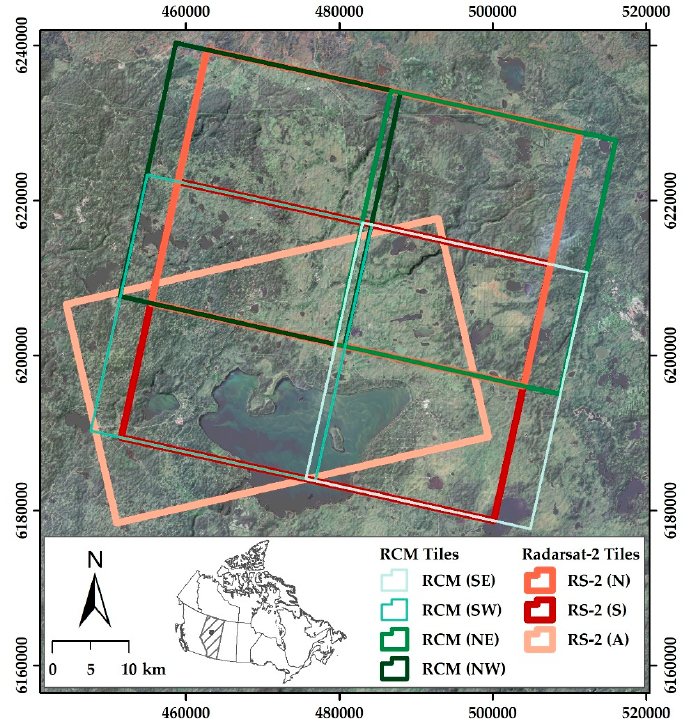
Figure 1. Study site location within Alberta, Canada. The spatial extents of the employed Synthetic Aperture Radar (SAR) images are illustrated by colours: descending orbit acquired Radarsat-2 (RS-2) north (N) and south (S) images, an ascending orbit acquired image (RS-2 (A)), and simulated (from Radarsat-2 images) Radarsat Constellation Mission (RCM) southeast (SE), southwest (SW), northeast (NE), and northwest (NW) images (for descending RS-2 images only).